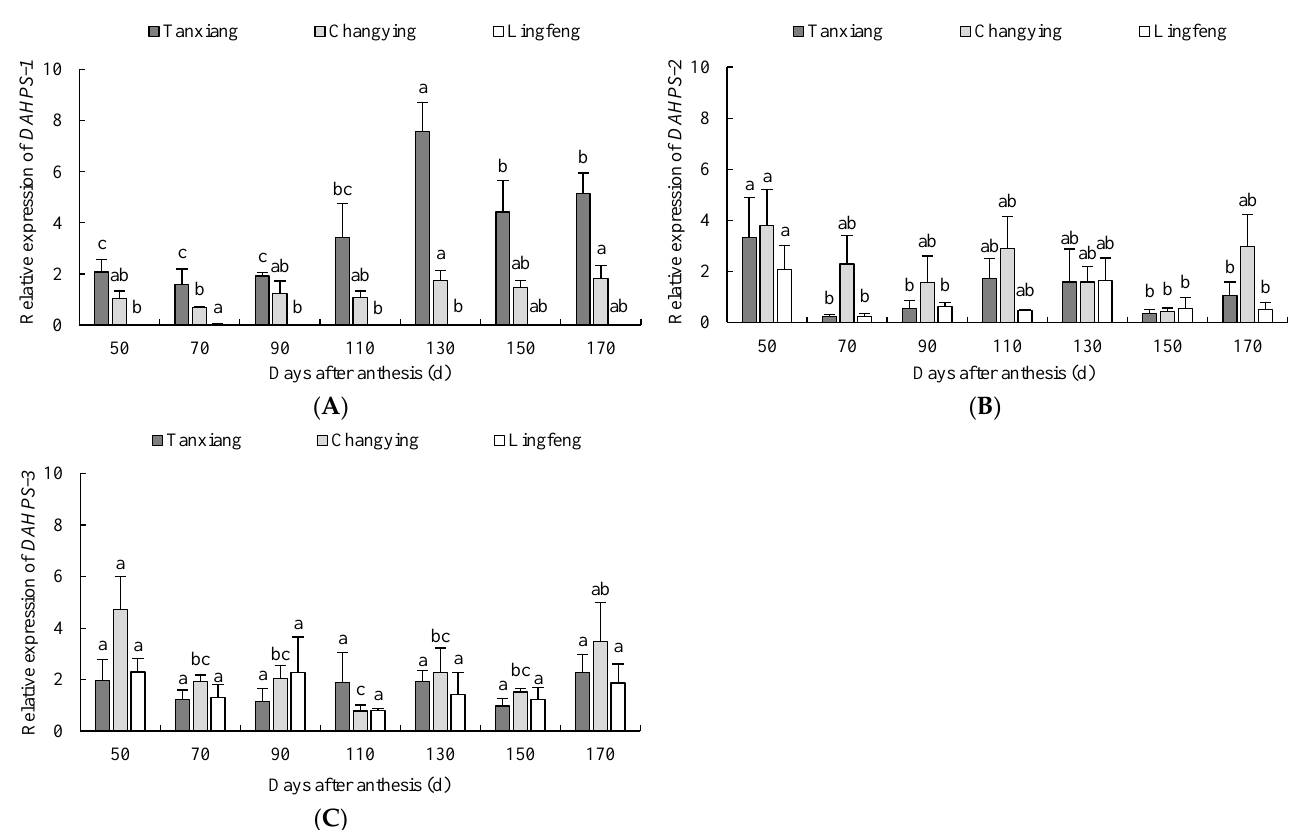
Figure 3. Expression of DAHPSs in Chinese olive fruit at different developmental stages. Bars rep- resent the standard deviation for three biological replicates. Different letters indicate significant dif- ferences among different stages of the same cultivars ( p < 0.05). ( A ) DAHPS-1 , ( B ) DAHPS-2 and ( C ) DAHPS-3 .